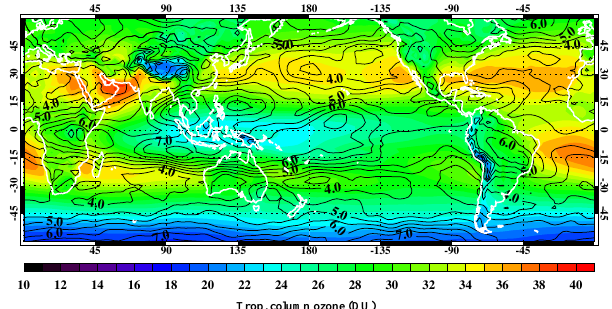
Figure 2. The 2005–2013 annual mean TCO (color contours) from the analyses. Black contours indicate one standard deviation of the deseasonalized TCO expressed as a percent of the annual mean TCO. Black contour interval is